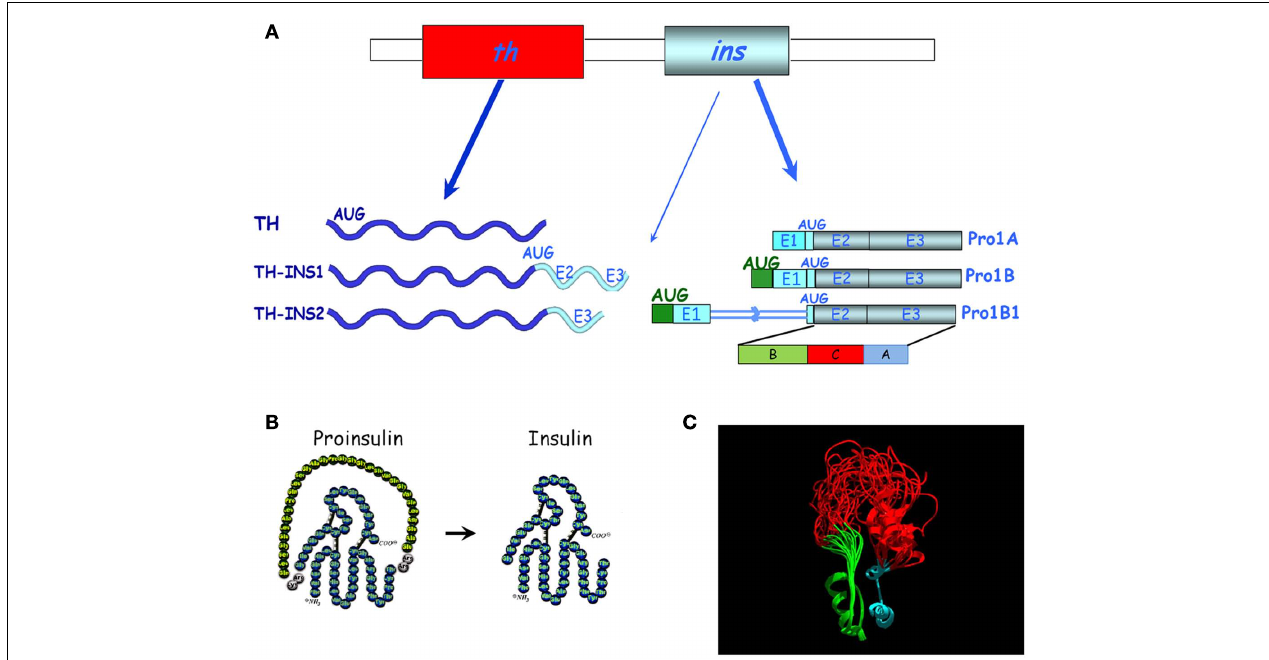
FIGURE 2 | Diversity of proinsulin transcripts and chimeric transcripts in chick embryos. (A) The canonical th and the pancreatic proinsulin mRNAs (Pro1A) are shown in the top panel. Below are alternative transcripts found in embryos, either chimeric mRNAs ( TH-INS1 , TH-INS2 ) or proinsulin mRNAs with an extended 5 (cid:2) UTR (Pro1B and Pro1B1).The translation initiation codon (AUG) and additional AUGs are indicated (modified from Hernández-Sánchez et al., 2006).The (B,C,A) protein domains of proinsulin are marked. E, exon.